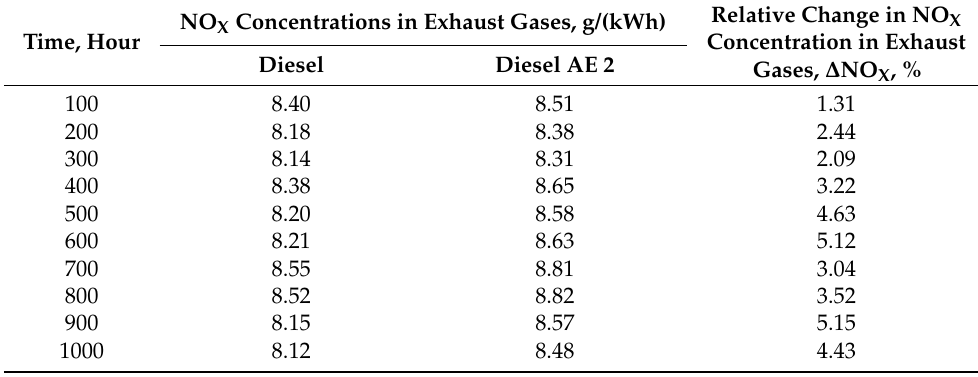
Table 8. Change in NO X concentrations in exhaust gases for the diesel 5L23/30 MAN-B&W Diesel Group under different experimental